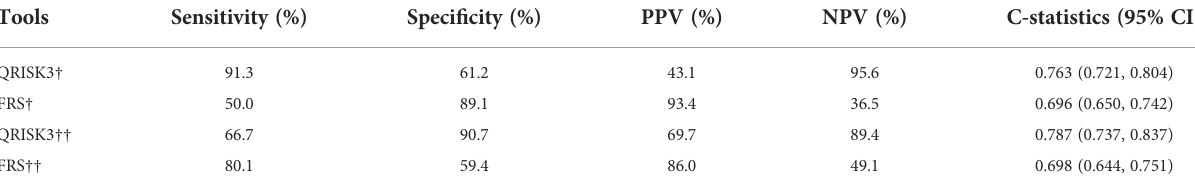
TABLE 3 Sensitivity, speci fi city, PPV, NPV and C-statistics of QRISK3 and FRS. Tools